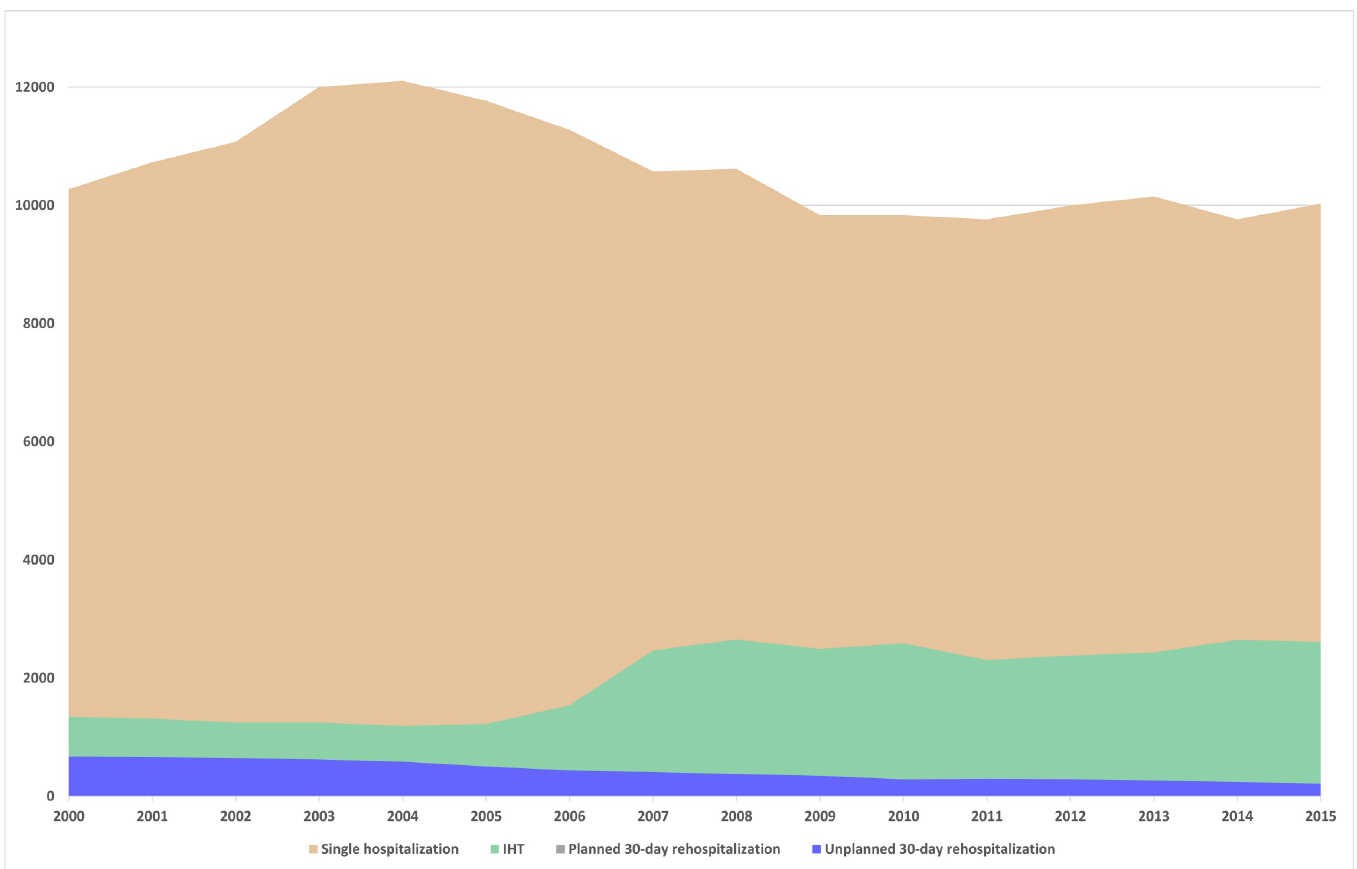
Fig 3. Number of ACS rehospitalizations, per year, for single hospitalization ACS-EC and for multiple hospitalizations ACS-EC.